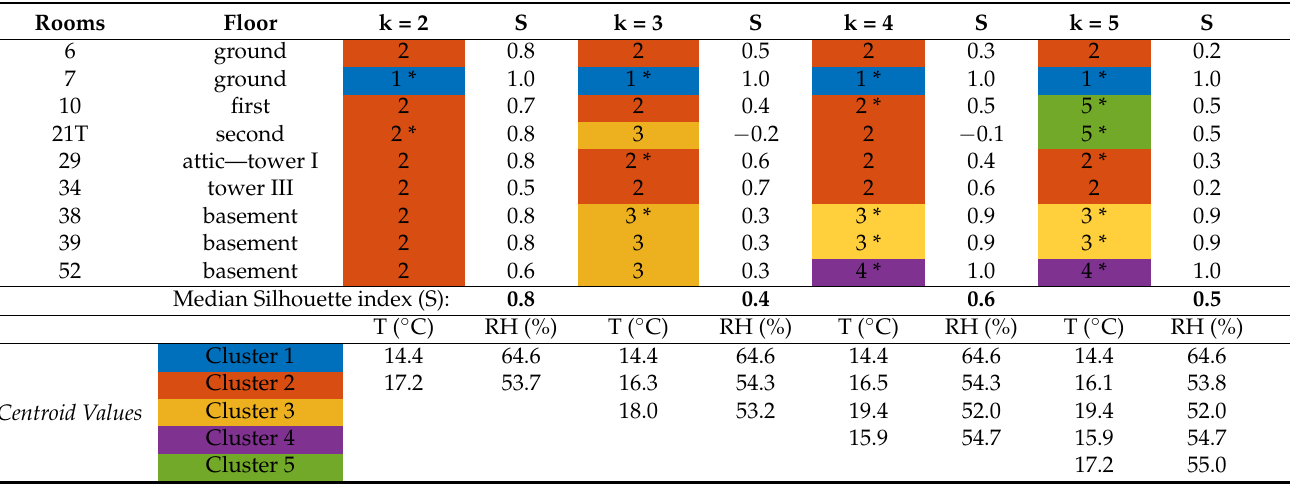
Table 5. Summary of k-mean cluster analysis (CA) applied to temperature (T) and relative humidity (RH) monthly data over the period from 1 June 2017 until 31 May 2018, in Rosenborg Castle. Table reports data on the cluster associated with each room; the individual Silhouette index (S) within the cluster; the median S over all clusters, and the centroid values for T and RH. The smallest distance from the centroid for each cluster is indicated by an asterisk (more than one asterisk is present for the same cluster in the case of equal smallest distances from the cluster